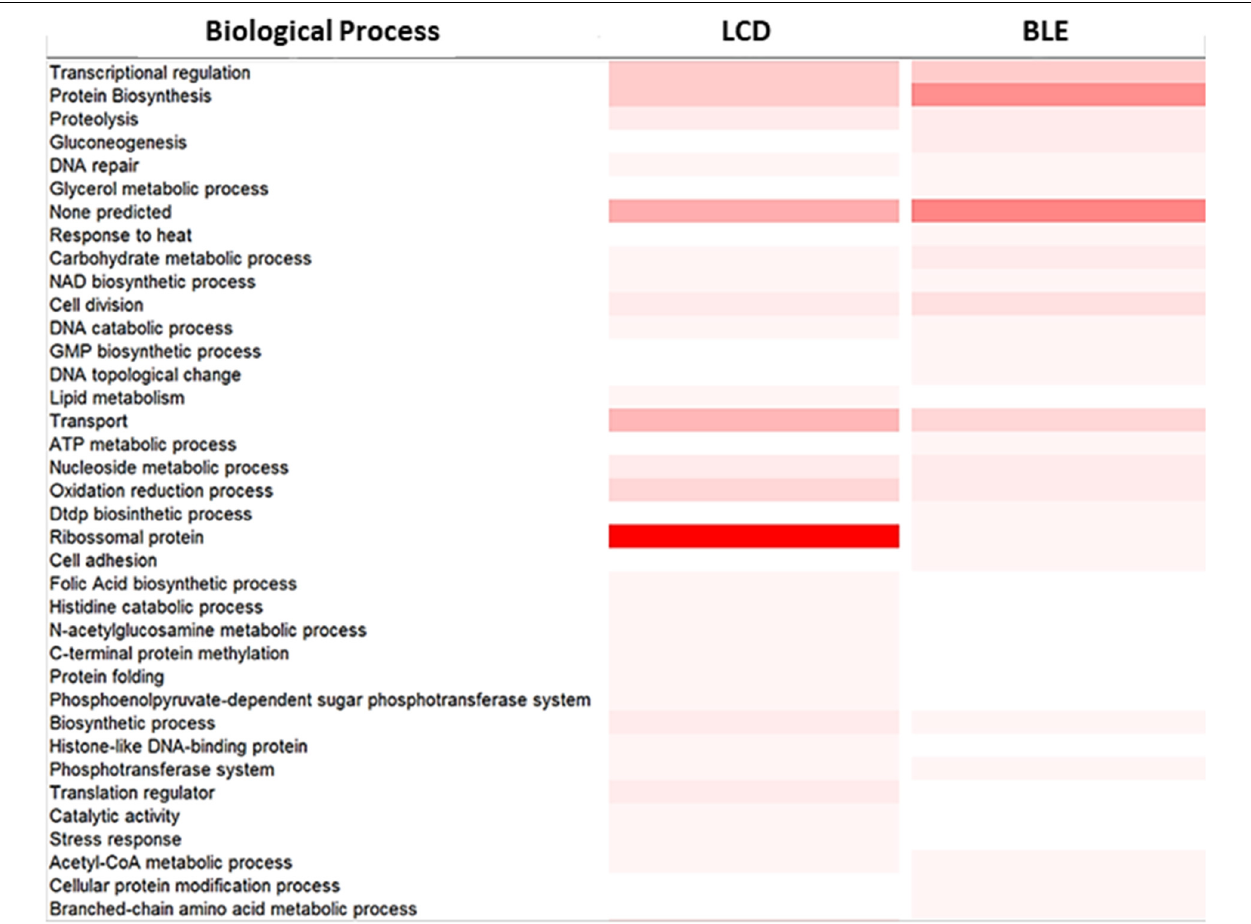
FIGURE 3 | Proteomic analysis of the Streptococcus pyogenes strain 37–97 in biofilm-like environment ( BLE ) and at condition of low cell density ( LCD ). Color gradient indicates the frequency of proteins involved in a biological process according to InterPro (www.ebi.ac.uk/interpro). More intense color : Highest number of proteins. Lightest color : smallest number of proteins. White color : absence of